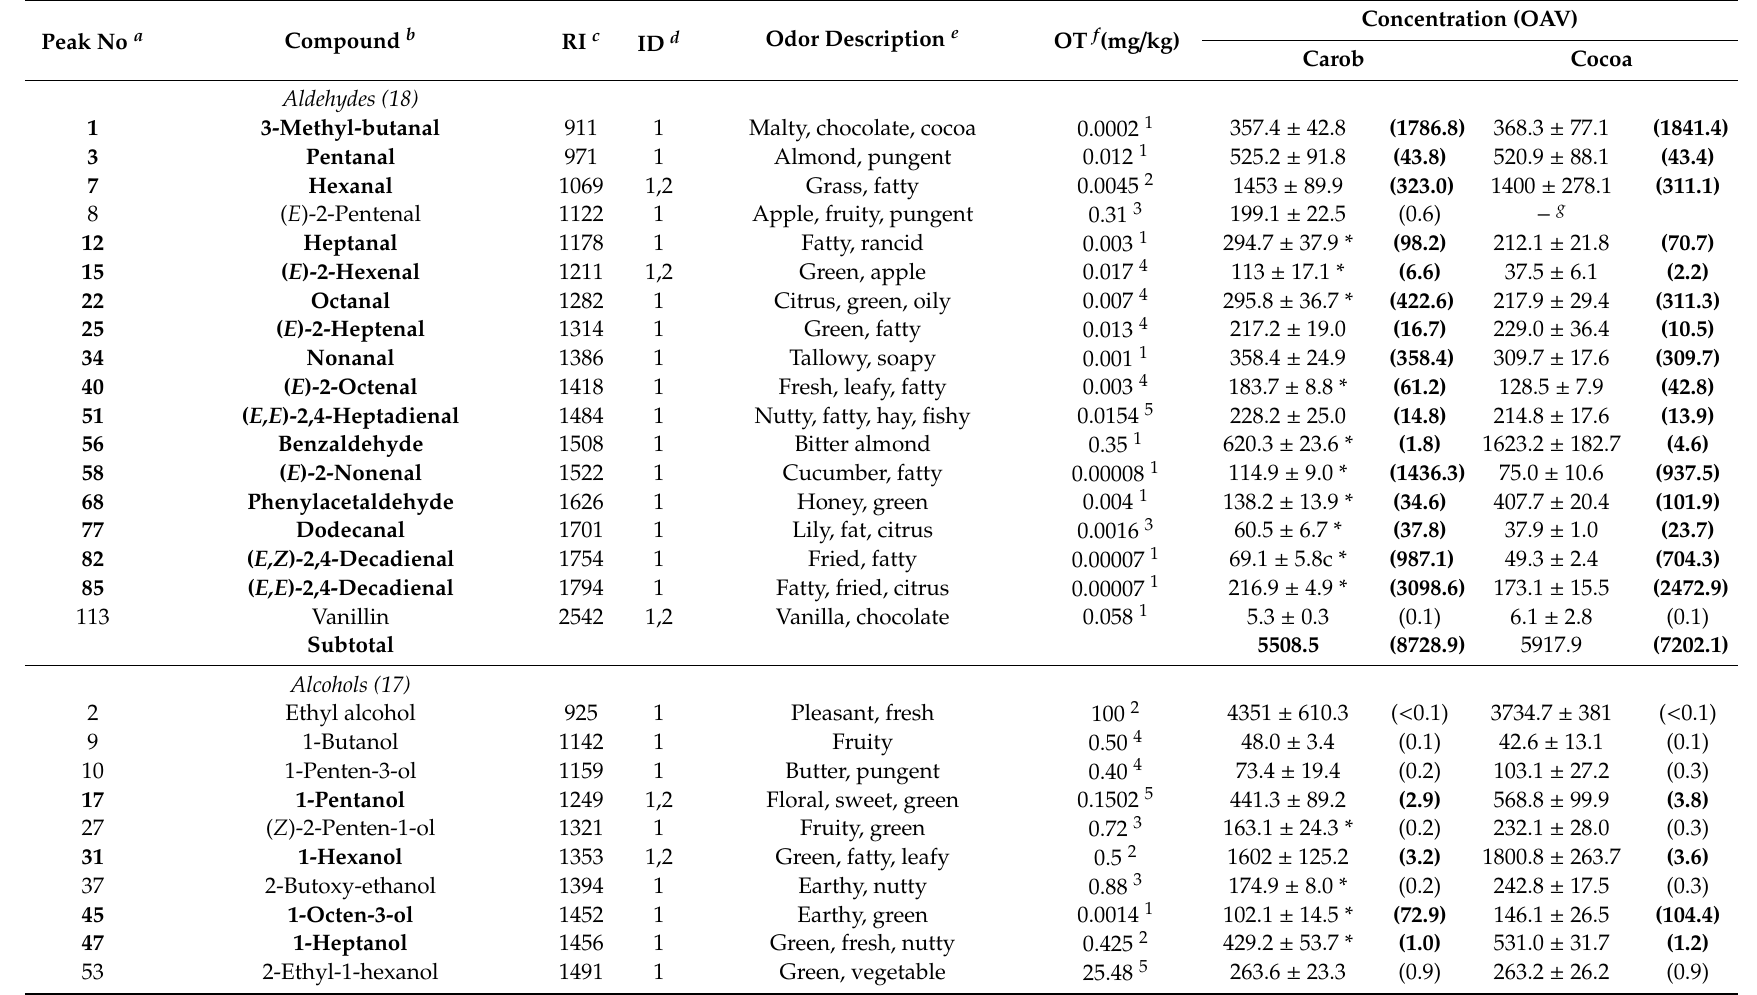
Table 5. Identification, odor description, odor threshold, concentration (mg / kg of sample) and Odor Activity Values (in parentheses) of volatiles detected in di ff erent cake